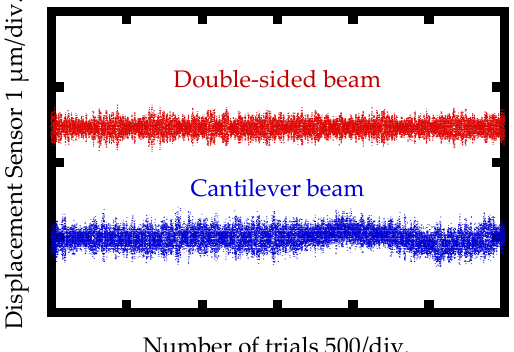
Figure 7. Stability of two kinds of profilers.